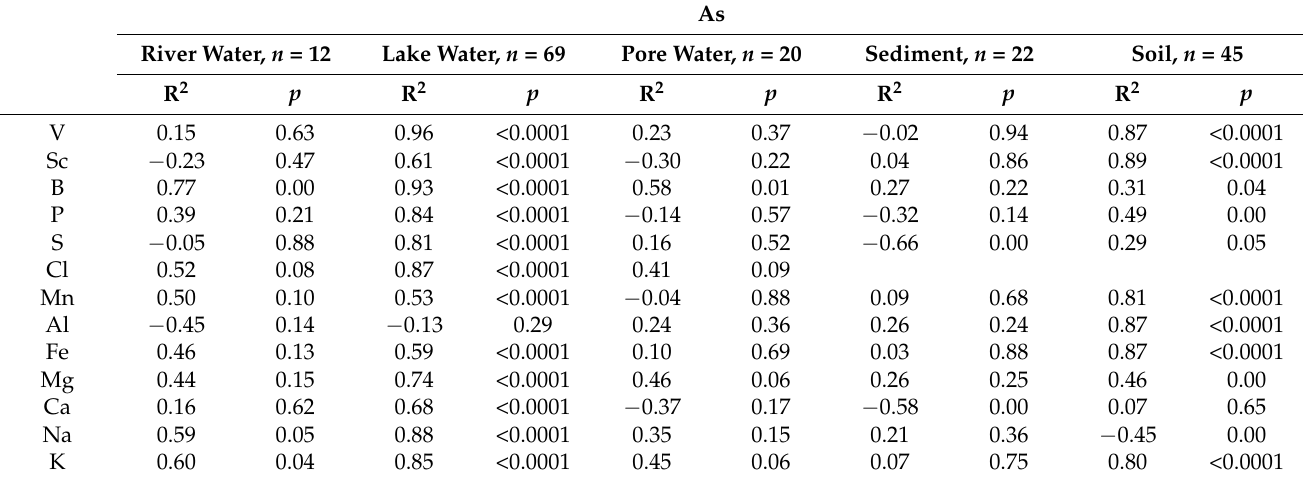
Table 3. Correlation coefficients of As with other elements in the water, sediment, and soil.